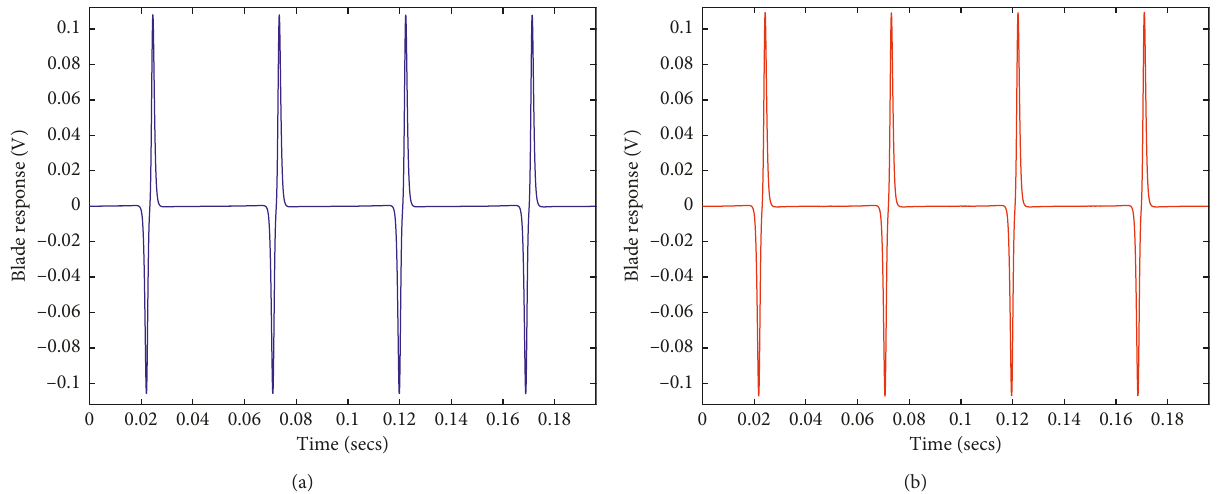
Figure 14: PECS reconstructed BTT signals of blade 8 for a speed of 100rpm. (a) Undamaged and (b) damaged